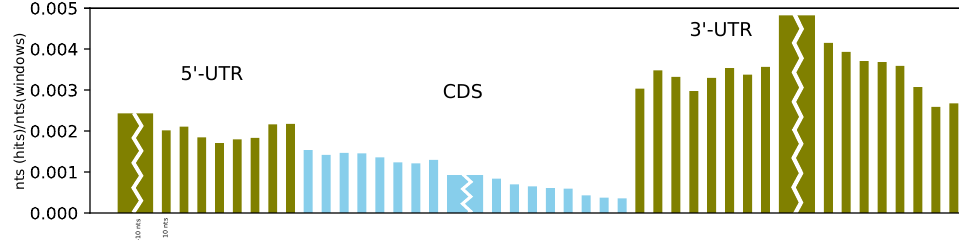
Figure 4. Profile of coverage by RNAz hits at different positions in the mRNA (olive: UTR, light blue: CDS). We plotted the number of nucleotides in RNAz hits at the given position over the number of nucleotides in the initial windows. Each narrow bar corresponds to a bin of 10 nucleotides. Only UTR and CDS annotations, which were long enough to cover all bins, were used. The slightly elevated coverage at the last two 5’-UTR bins may be an artefact of the 20nt flanking regions, where alignments in the CDS are extended slightly into the 5’-UTR. It is visible here, since (due to better alignability) there are more aligned nucleotides in the CDS than in the